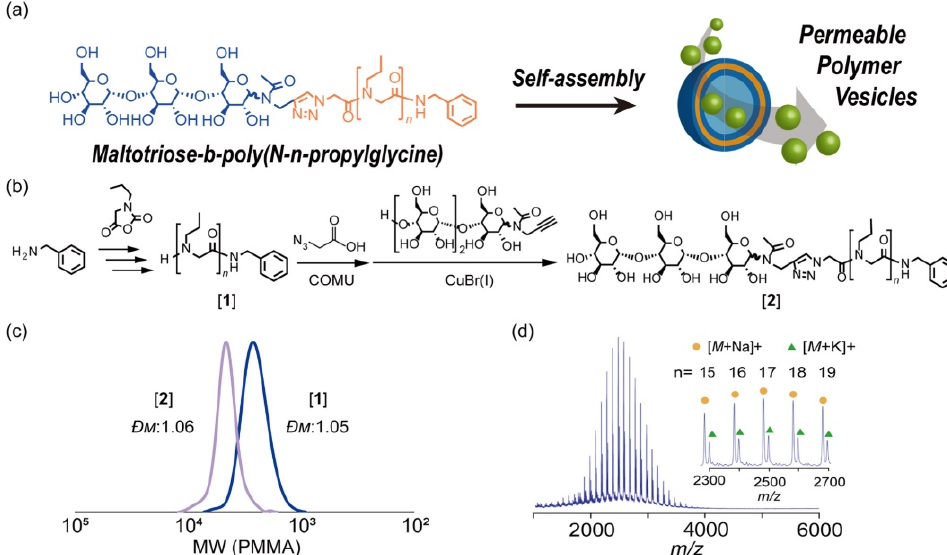
Figure 7. ( a ) Chemical structure of maltotriose- b -poly( N -n-propyl glycine) block copolymer and schematic of self-assembly into solute-permeable vesicles. ( b ) Synthetic scheme of maltotriose- b - poly( N -n-propylglycine). ( c ) Size exclusion chromatograms of polymers ( N , N -dimethylformamide containing 10 mM LiBr as an eluent). ( d ) Matrix-assisted laser desorption/ionization time-of-flight mass spectroscopy(MALDI − TOF − MS) data of maltotriose- b -poly( N -n-propyl glycine) 17 (Adapted from ref. [64]. Copyright 2021, American Chemical Society).